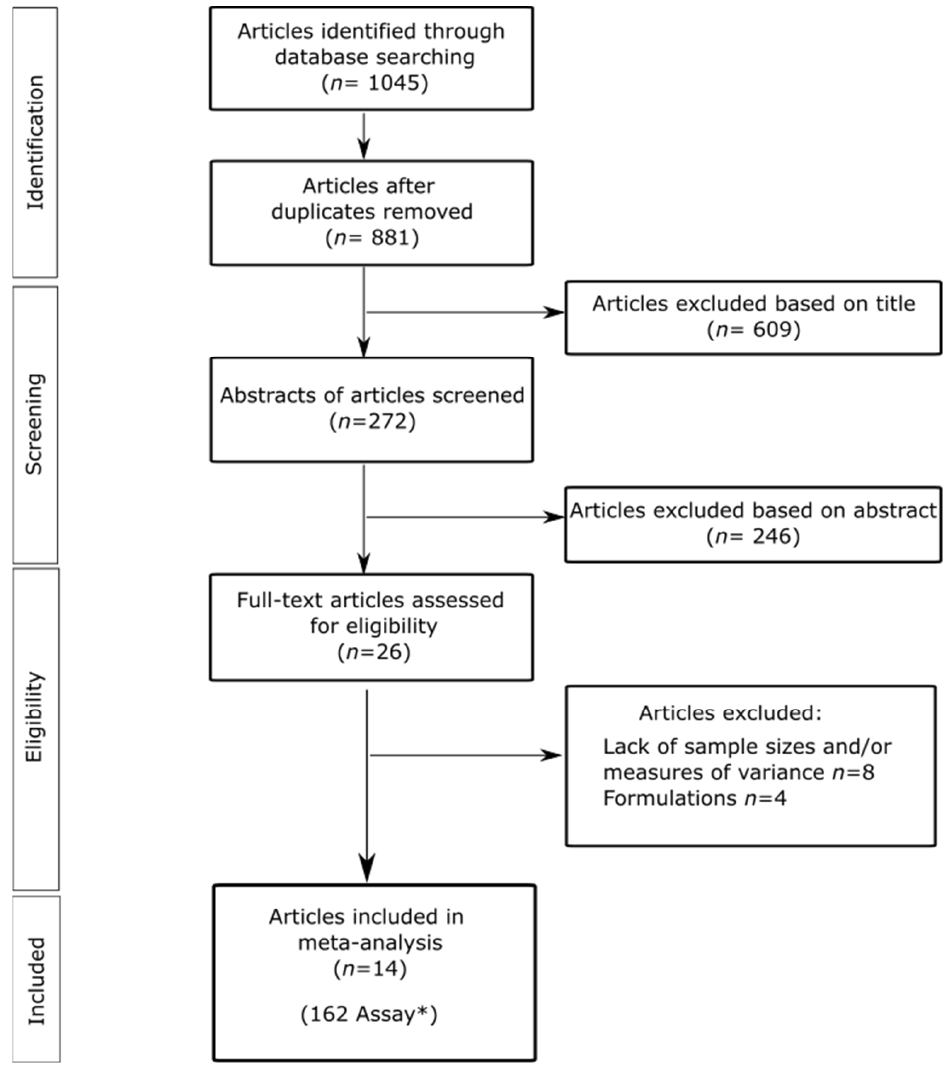
Figure 1. Flowchart for the selection of articles according to the criteria established for systematic reviews and meta-analysis (PRISMA). * Each trial for the meta-analysis was defined for a given plant EO/exposure time/max-min concentration of EO/mealybug species tested/development stage of insect/method of application.